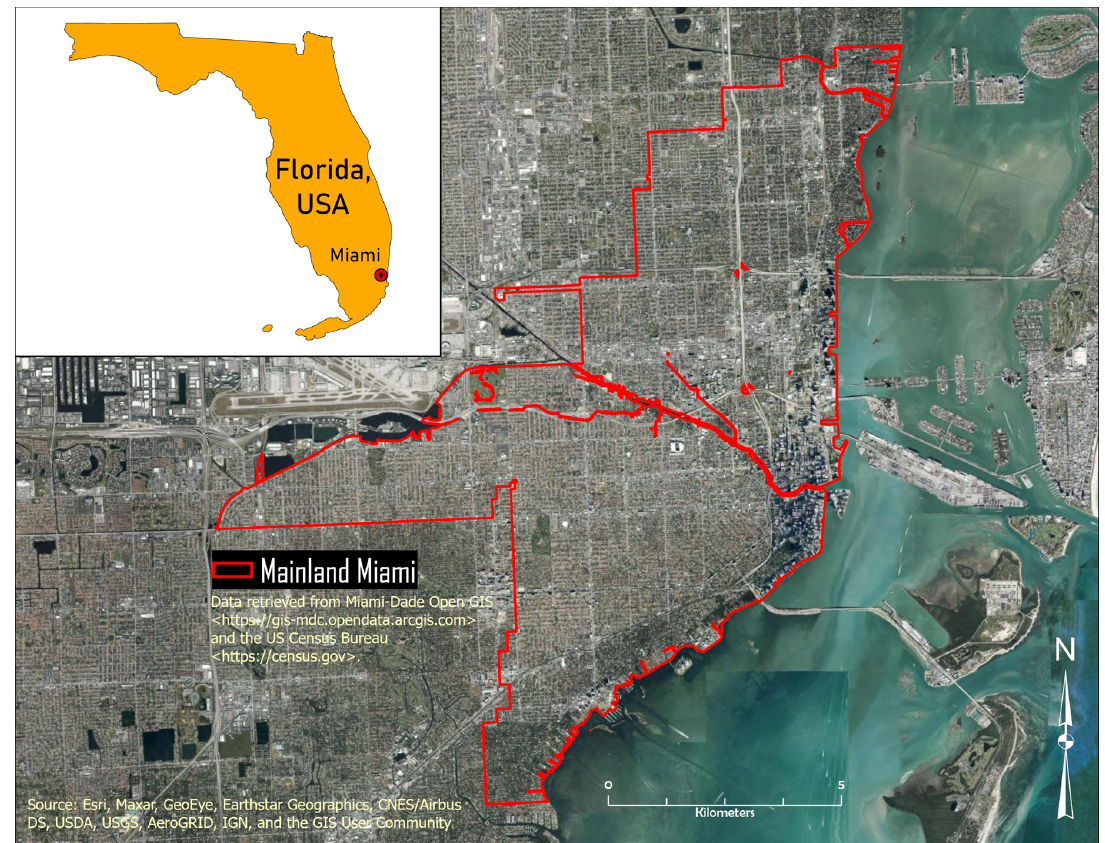
Figure 1. Miami sits on the southeastern tip of Florida. The city is enclosed by Biscayne Bay and the Atlantic Ocean to the east, and urbanized parts of Miami-Dade County inland.